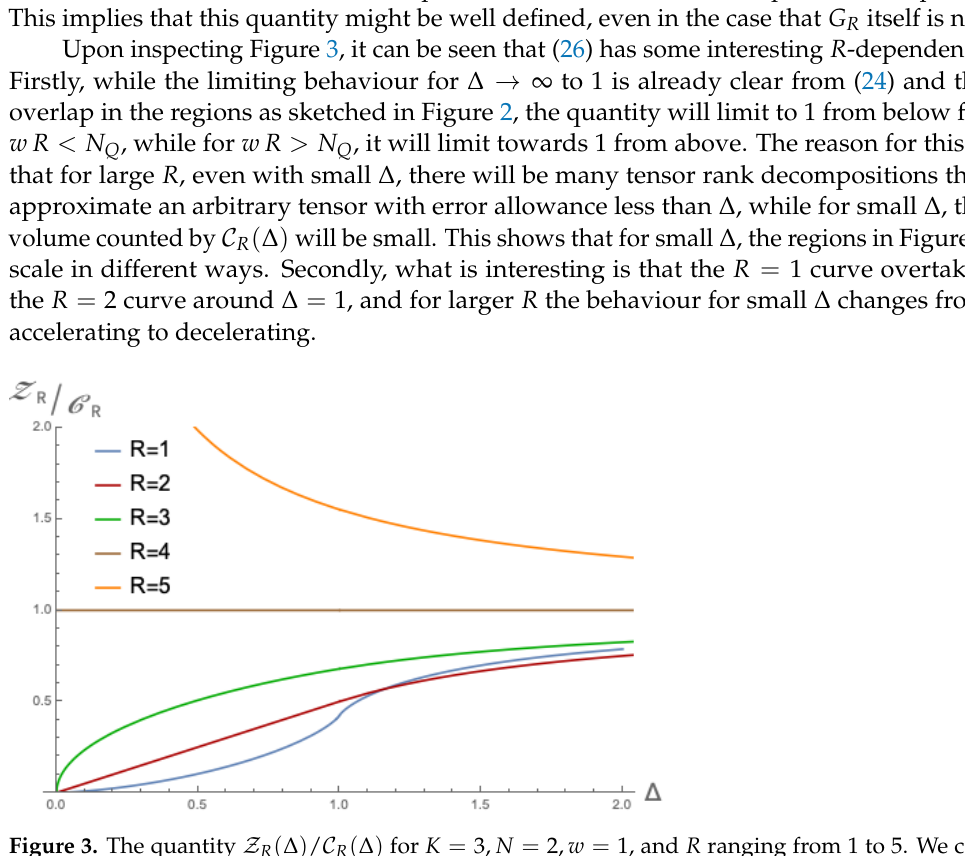
Figure 3. The quantity Z R ( ∆ ) / C R ( ∆ ) for K = 3, N = 2, w = 1, and R ranging from 1 to 5. We can identify some of the behaviour expected from (26) and (24). For any value of R , the function nears 1 for ∆ → ∞ . For w R = N Q , the function is just one